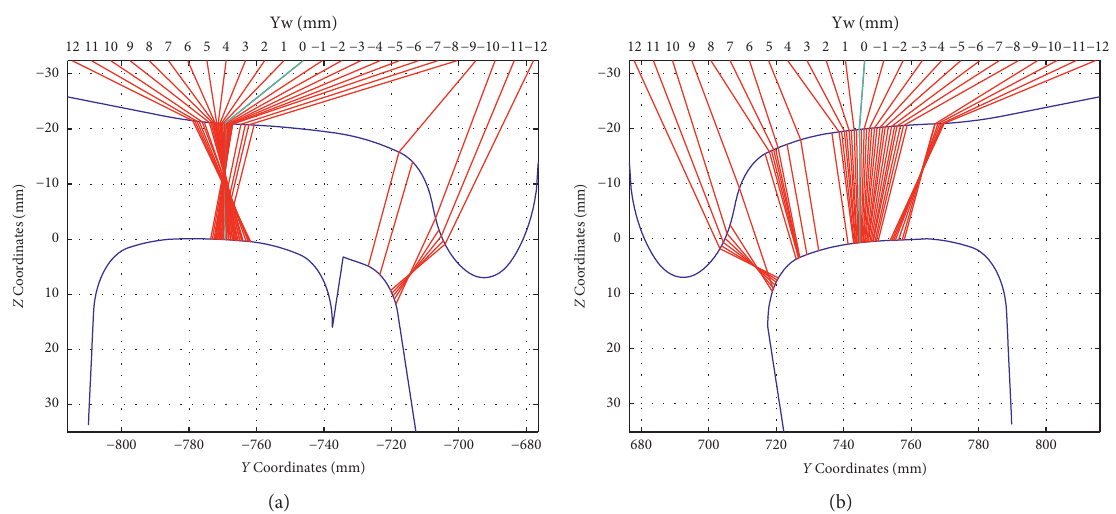
Figure 17: Distribution of wheel-rail contact points after optimization: (a) switch rail and (b) stock rail.